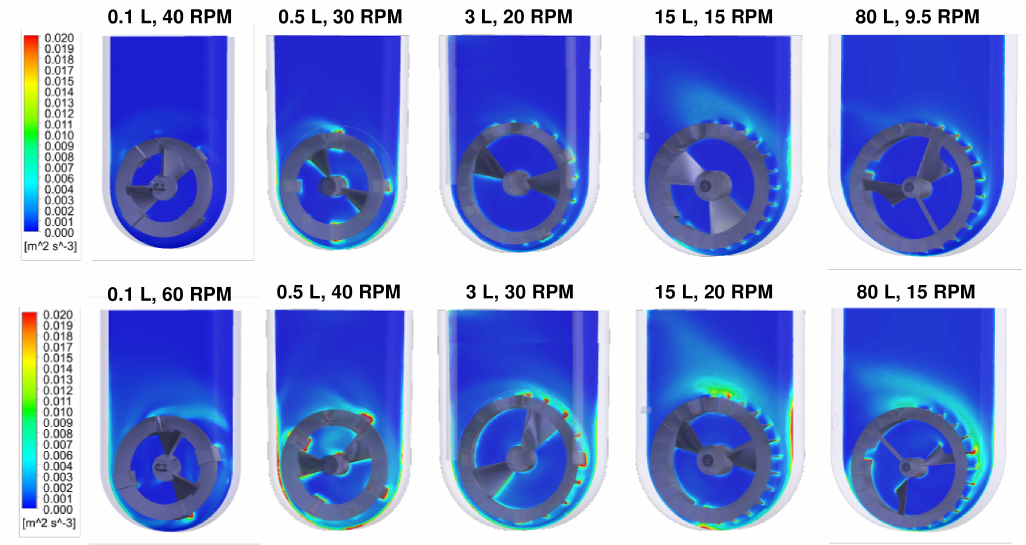
Figure 2. CFD models of EDR contours for various scales and agitation rates in VW bioreactors. A narrow distribution of EDR, which promotes formation of uniformly spherical aggregates, can be maintained during scale up in VW bioreactors. Adapted from Dang et al. (2021)